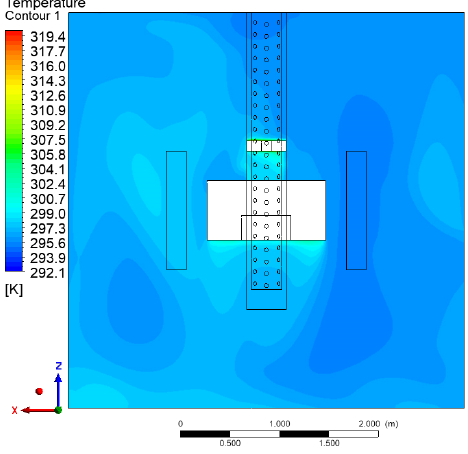
Figure 16. The temperature distribution of the Y = 0.6 m section.